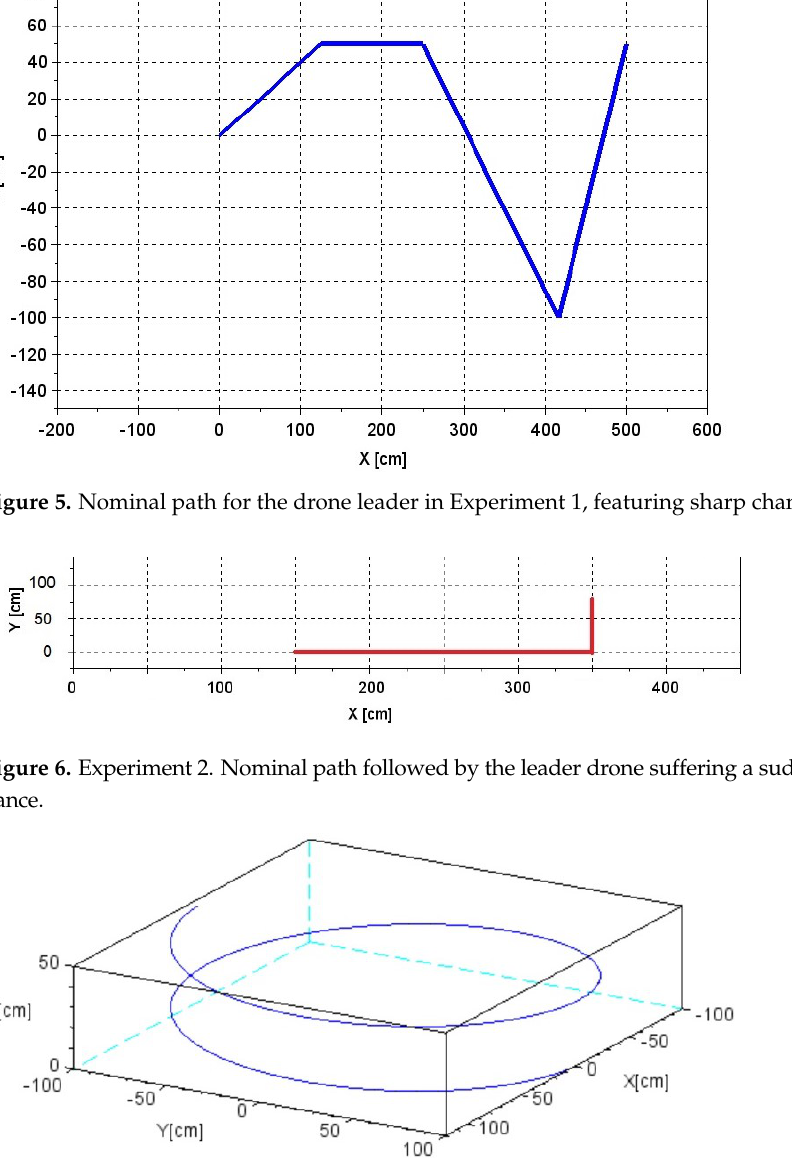
Figure 7. Spiral 3D ascending path in Experiment